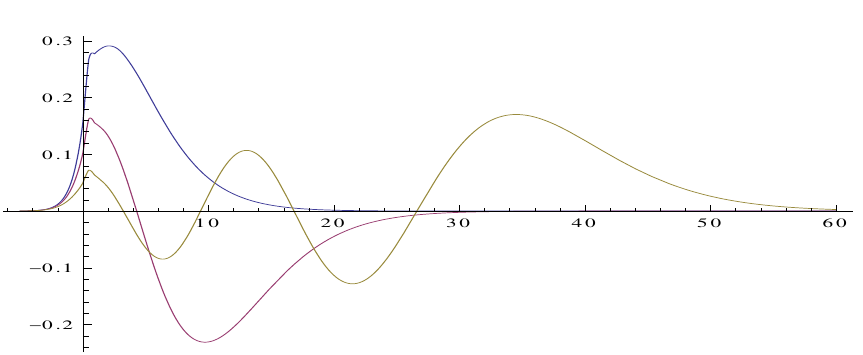
Figure 24 . Three leading wavefunctions (No 1,2,5) for the scale k = 0 : 54 GeV, as a function of ln q 2 .